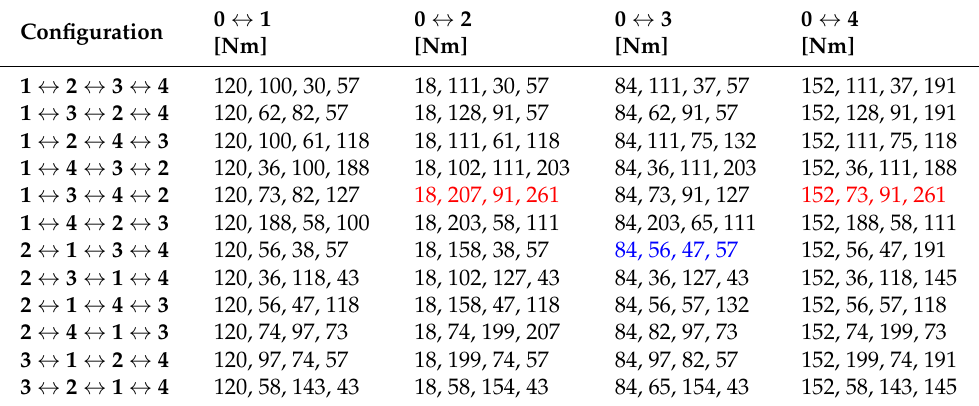
Table 5. Maximum shaft torques for linear VDN topology interconnection schemes in crane applica- tion. The Blue colored case marks the scheme with the lowest torque sum and the red colored cases mark the schemes with the highest torque sum.